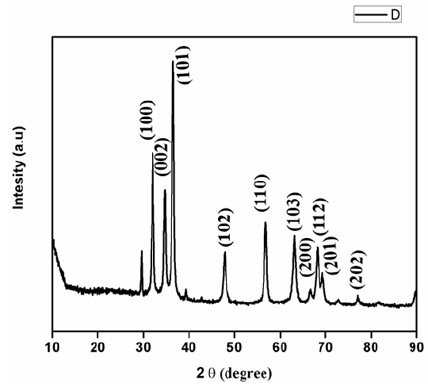
Figure 4. XRD analysis of